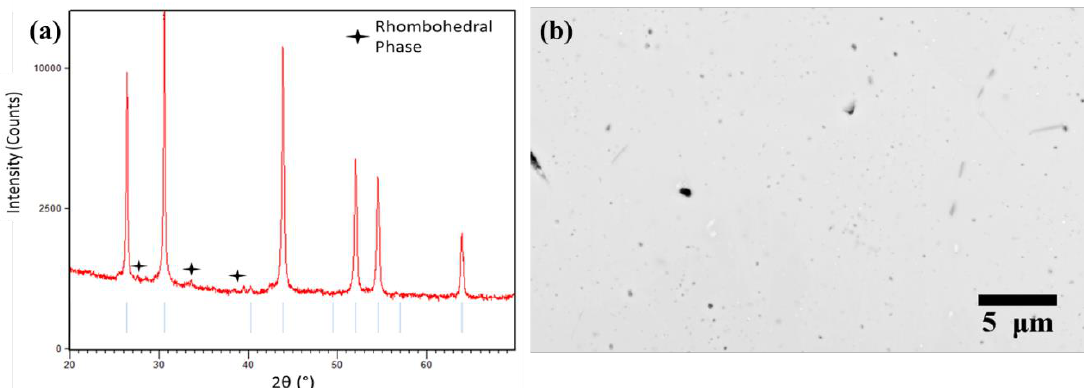
Figure 1. ( a ) Powder X-ray diffraction pattern of Sc 2 Te 3 sample. The pattern agrees well with the Sc 2 Te 3 phase (blue lines). A small amount of the rhombohedral Sc 2 Te 3 phase was detected and marked. ( b ) Back-scattered electron (BSE) SEM micrograph of the polished surface of the Sc 2 Te 3 . Dark regions are from residual porosity present in the sample. A small number of Fe contaminants (light regions) were observed and confirmed through energy dispersive X-ray spectroscopy (EDS).